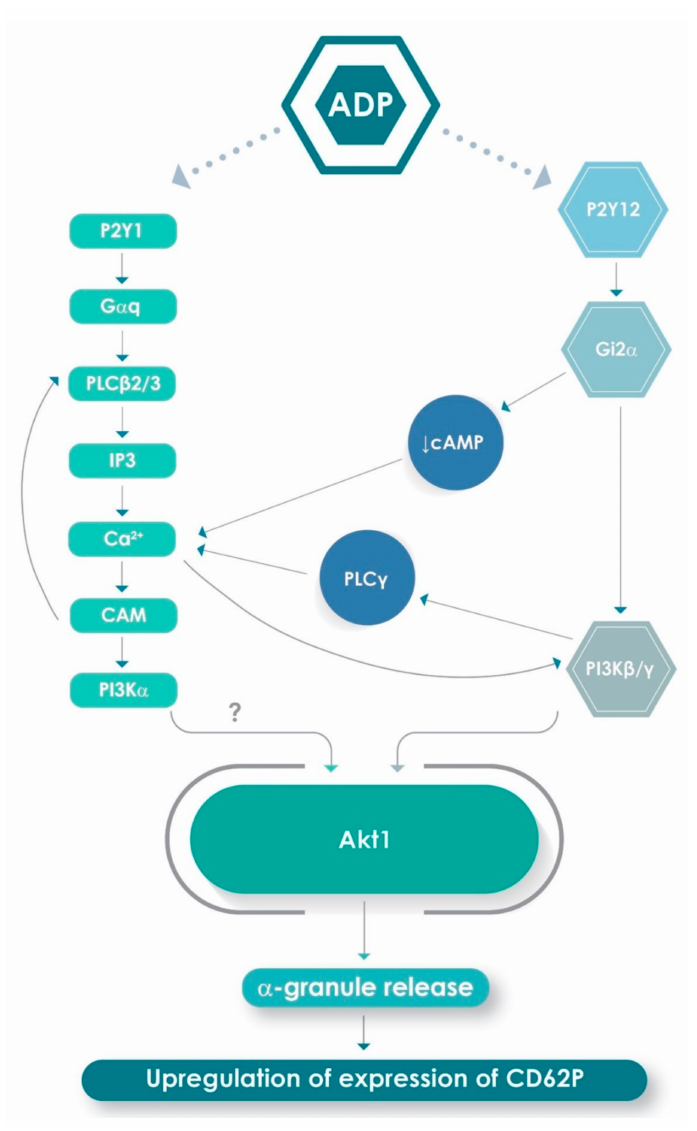
Figure 6. Proposed mechanism by which P2Y1 and P2Y12 platelet purinergic receptors harmonize to induce platelet α -granule release and upregulation of expression of CD62P. Interaction of ADP with P2Y1 G α q protein-coupled receptors and P2Y12 Gi2 α protein-coupled receptors leads to triggering of an initially divergent series of intracellular signalling events. In the case of P2Y1, ligation of ADP results in activation of phospholipases C (PLC) β 2 and β 3, mobilization of intracellular Ca 2 + and possibly calmodulin (CAM)-mediated activation of the α -isoform of phosphatidylinositol 3-kinase (PI3K, indicated by ?). This series of intracellular, Ca 2 + -dependent signalling events is augmented via activation of P2Y12 receptors due to Gi2 α protein-mediated: (i) inhibition of adenylyl cyclase, preventing re-sequestration of cytosolic Ca 2 + ; and (ii) recruitment of the β - and γ -isoforms of PI3K, which, in turn, activate the γ -isoform of PLC. Activation of PLC γ is further augmented via PI3K β / γ interactions, augmenting the high cytosolic Ca 2 + milieu seemingly necessary for optimal activity of PI3K. Finally, the activated isoforms of PI3K harmonize to promote activation of Akt1, a seemingly critical event in mobilization of platelet α -granules and upregulation of expression of